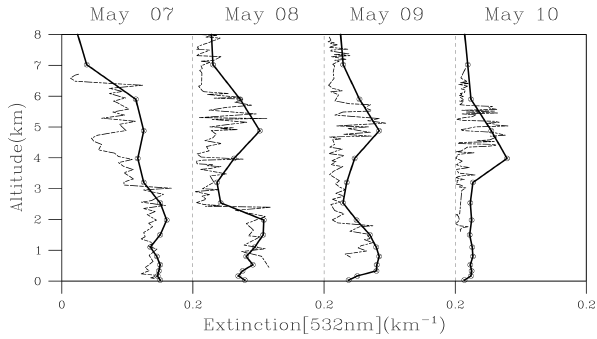
Fig. 12. Comparison of vertical distribution of Asian dust between model simulations and CALIPSO observations in May of